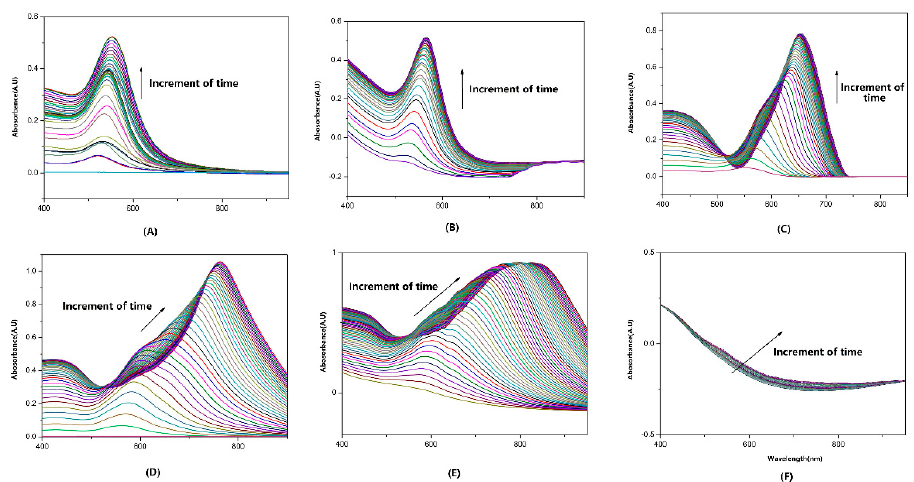
Figure 2. The variety of absorbance spectra during the ( A ) 20 nm, ( B ) 40 nm, ( C ) 60 nm, ( D ) 80 nm, ( E ) 100 nm, and ( F ) 150 nm AuNS immobilizing processes.